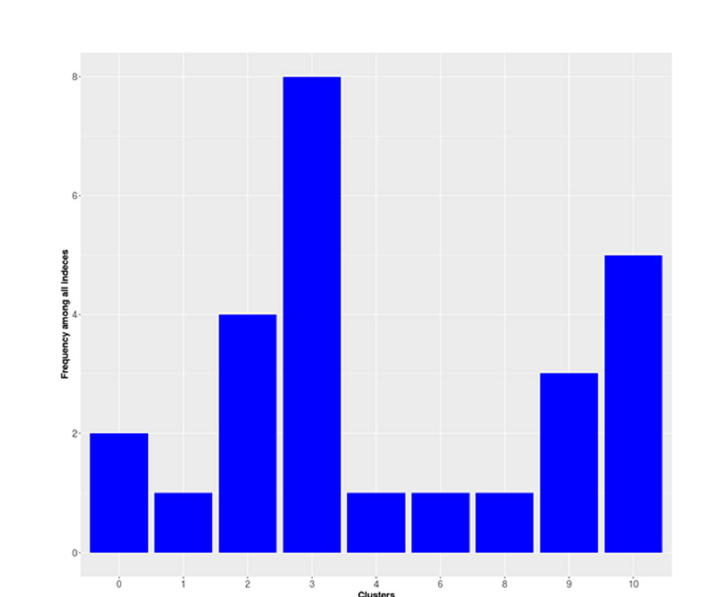
Land 2020 , 9 , x FOR PEER REVIEW Figure 2. Optimal number of clusters. Source: author’s own elaboration. Figure 2. Optimal number of clusters. Source: author’s own elaboration.